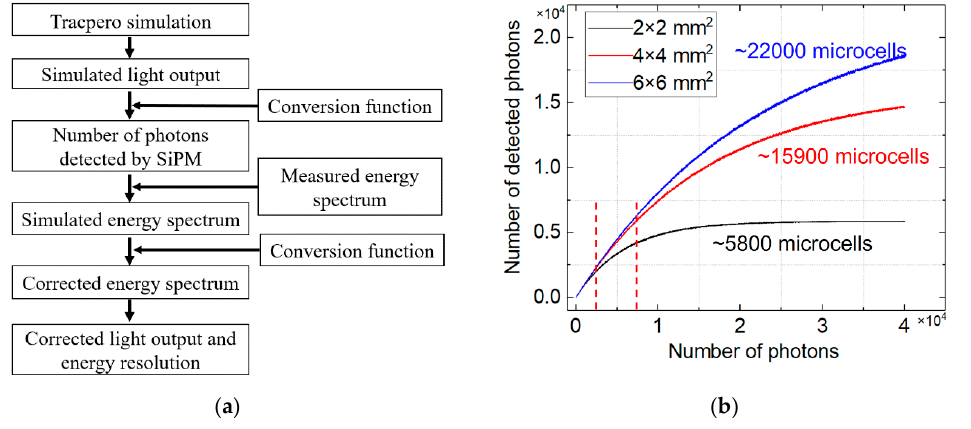
Figure 6. ( a ) Flowchart of the saturation correction; ( b ) conversion function. Table 5. Characteristic parameters of the tested crystals.